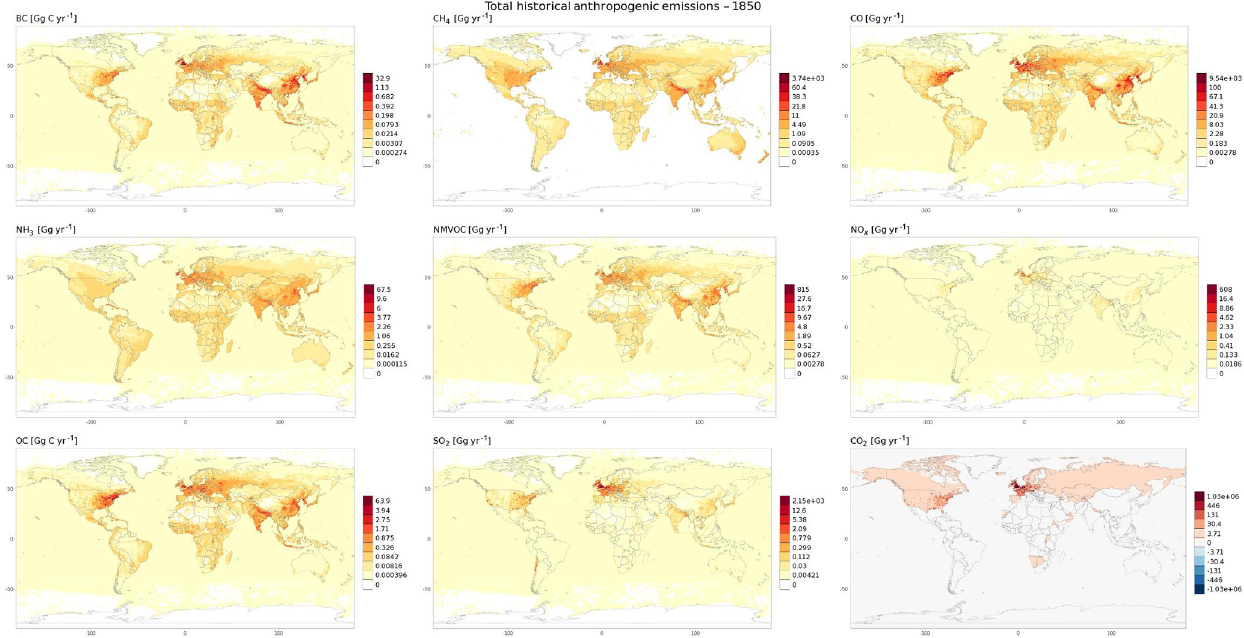
Figure 3. Total anthropogenic emissions in 1850 by species. The color scale is the same for each emission species across all gridded figures for comparison. Note that the CO 2 color scale accommodates the net negative emissions found in some future scenarios.